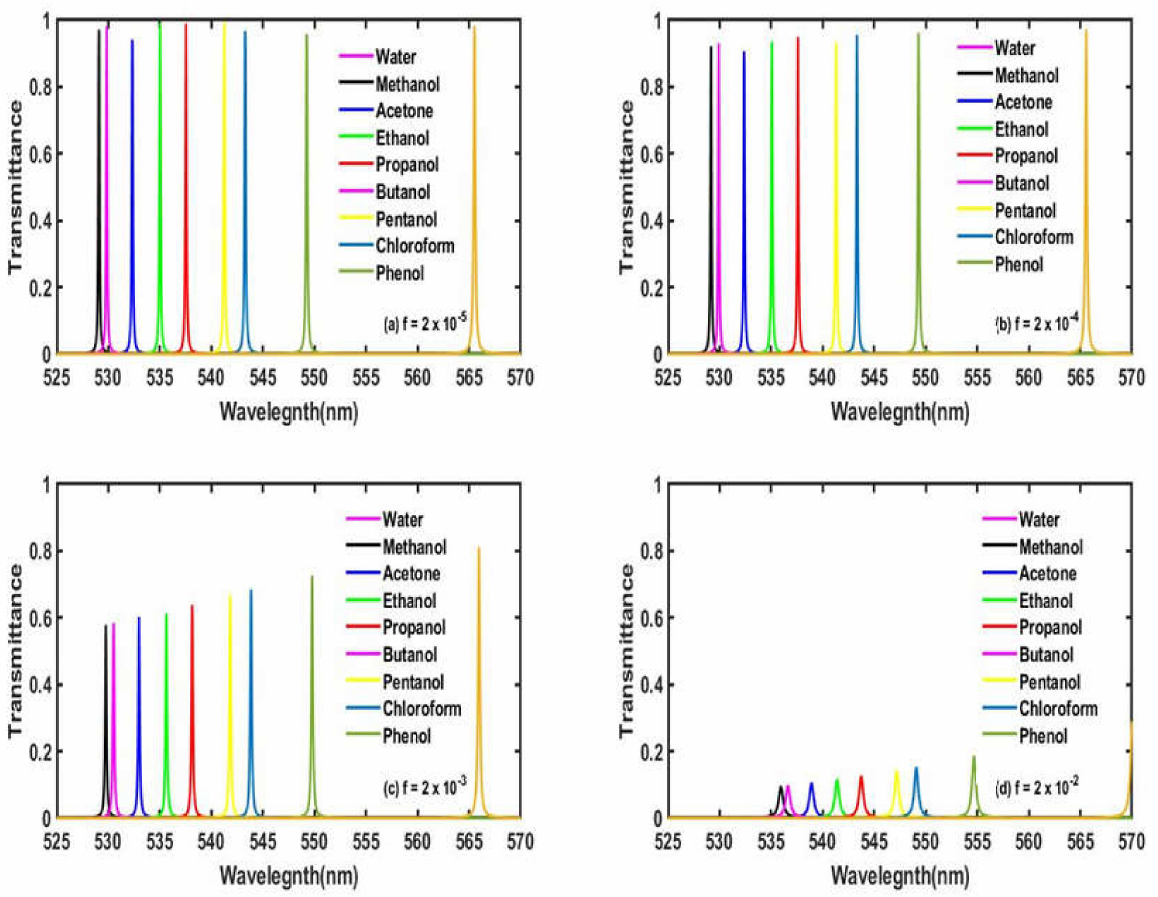
Figure 6. The transmittance spectra of the proposed bio-alcohol sensor loaded separately with water samples containing methanol, acetone, ethanol, propanol, butanol, pentanol, chloroform and phenol, each of a concentration of 30% with respect to pure water samples at a normal incidence with d c = 125 nm corresponding to different values of the volume fraction of Ag nanoparticles of nanocomposite material layers ( a ) f = 2 × 10 − 5 , ( b ) f = 2 × 10 − 4 , ( c ) f = 2 × 10 − 3 and ( d ) f = 2 × 10 − 2